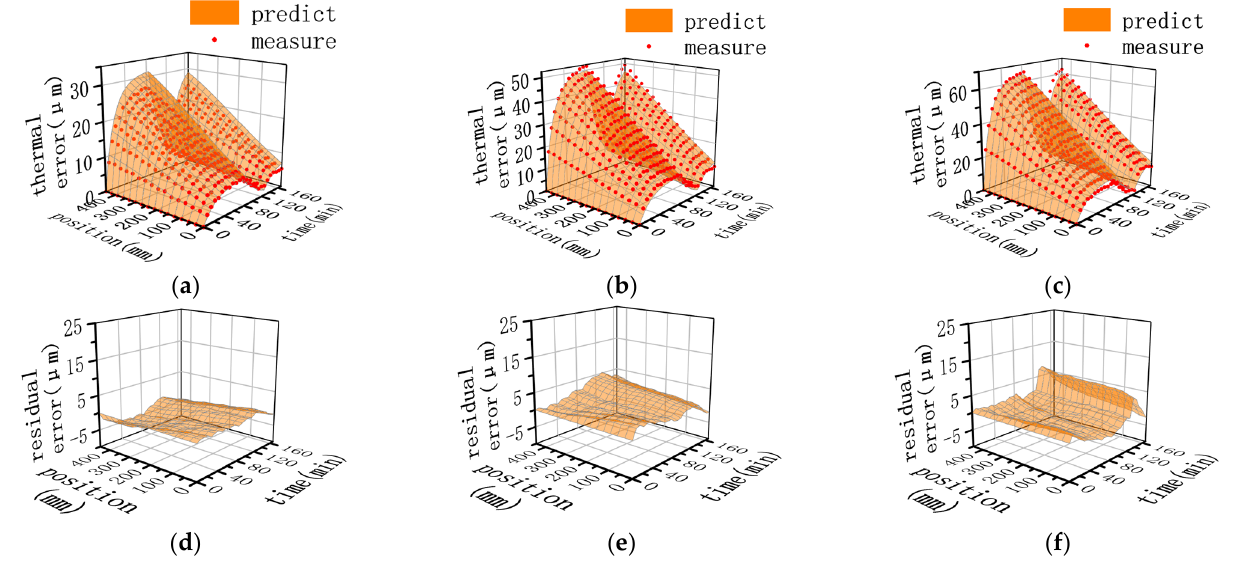
Table 3. Identified parameters of each axis.